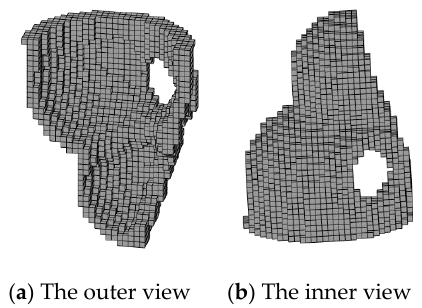
Figure 13. The reconstructed model in MATLAB.